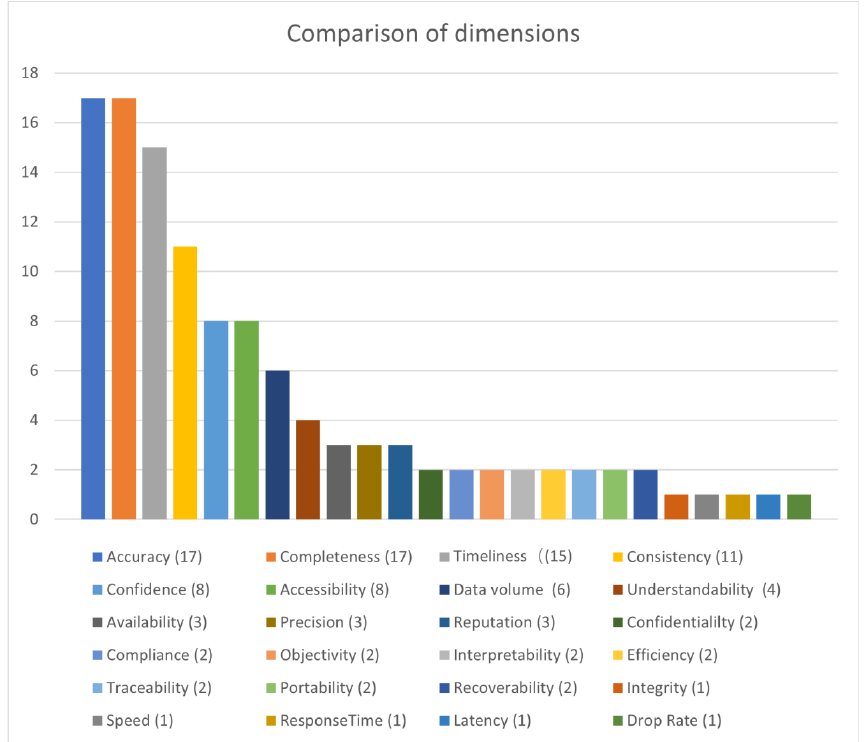
Figure 5. Comparison of